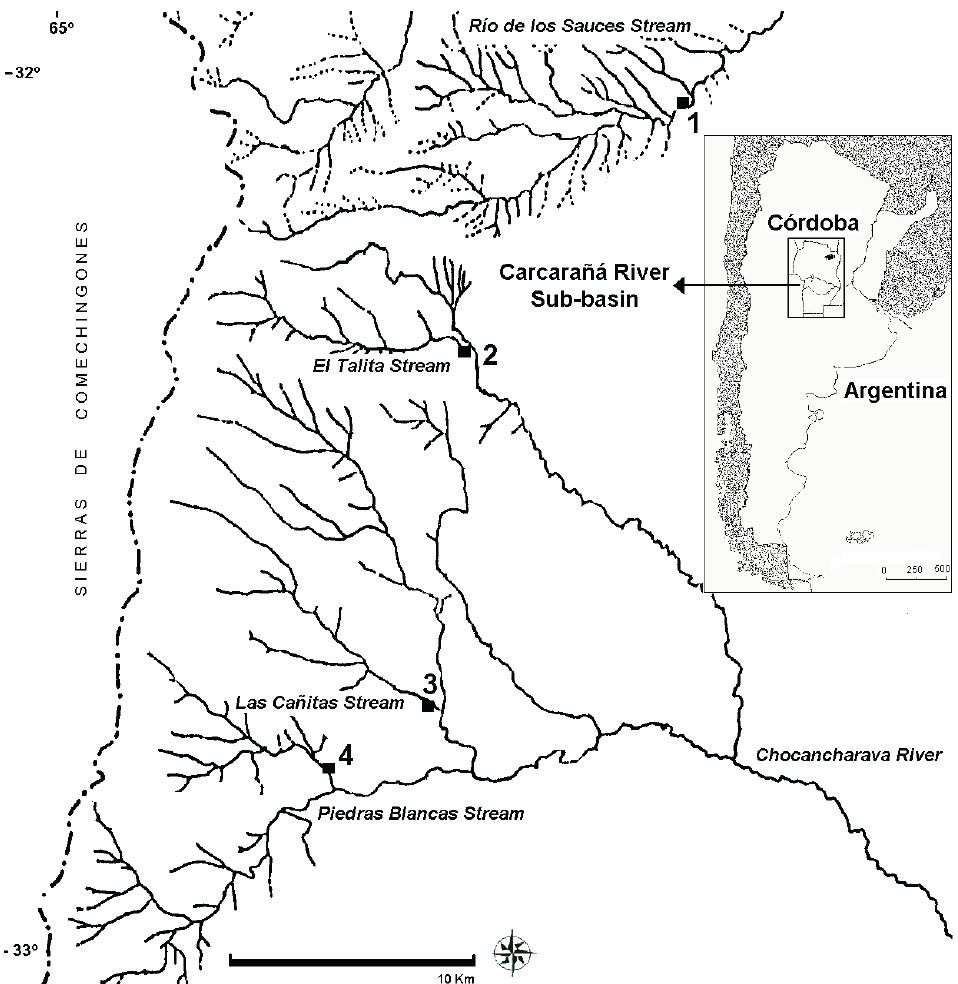
Figure 1 - Study streams in the Carcarañá River Basin, Córdoba, Argentina: (1) Río de los Sauces, (2) el Talita, (3) las Cañitas, (4) Piedras